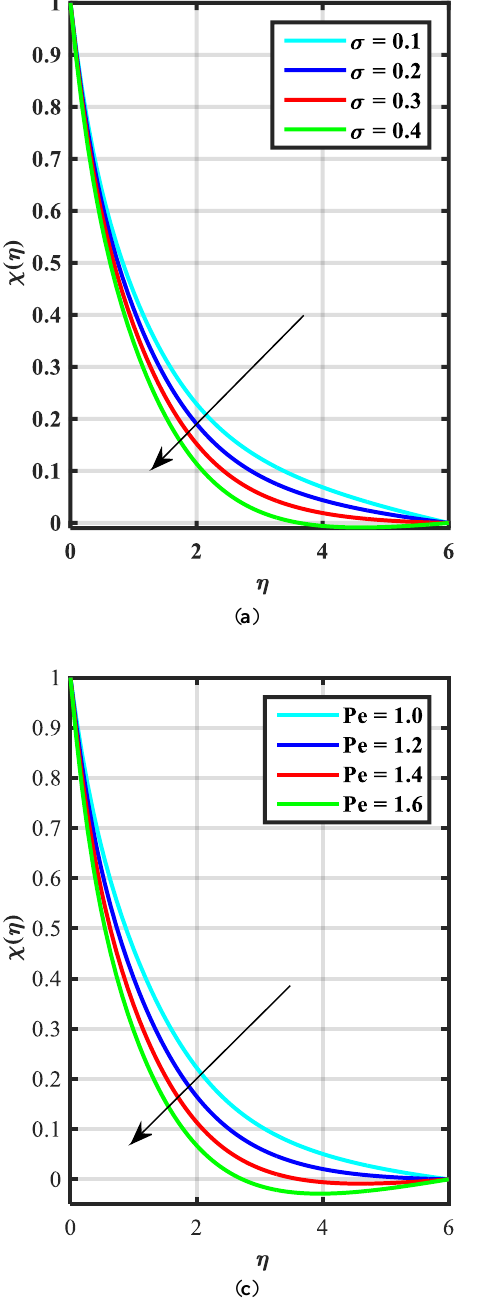
Figure 10. ( a – c ) Influence of χ ( η ) over bioconvection parameter σ , Lewis number Lb, and Peclet number Pe